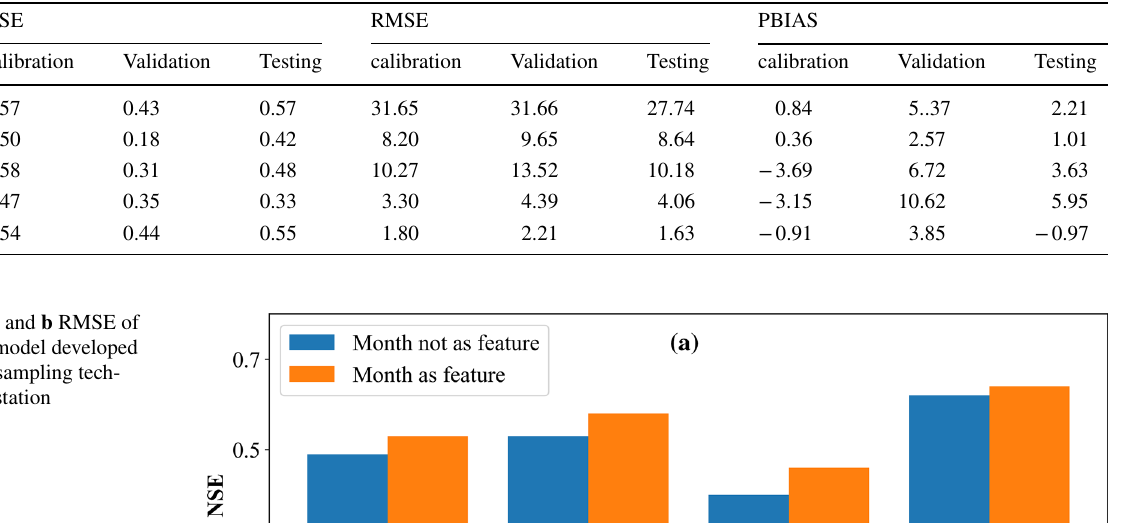
Table 5 Performance criteria for direct prediction using LSTM model Station